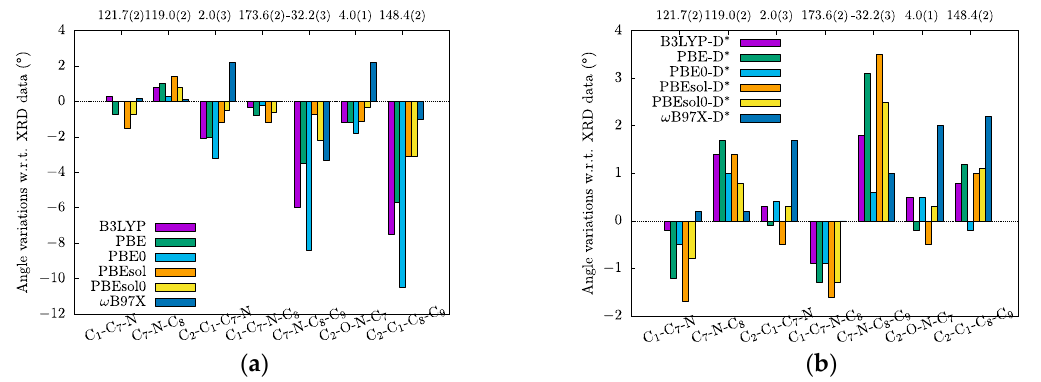
Figure 4. Differences between the angles of the optimized structure and of the XRD data as a function of the XCF, Δ = [a(DFT) − a(XRD)]: ( a ) with DFT; ( b ) with DFT-D*. The XRD values are given on the